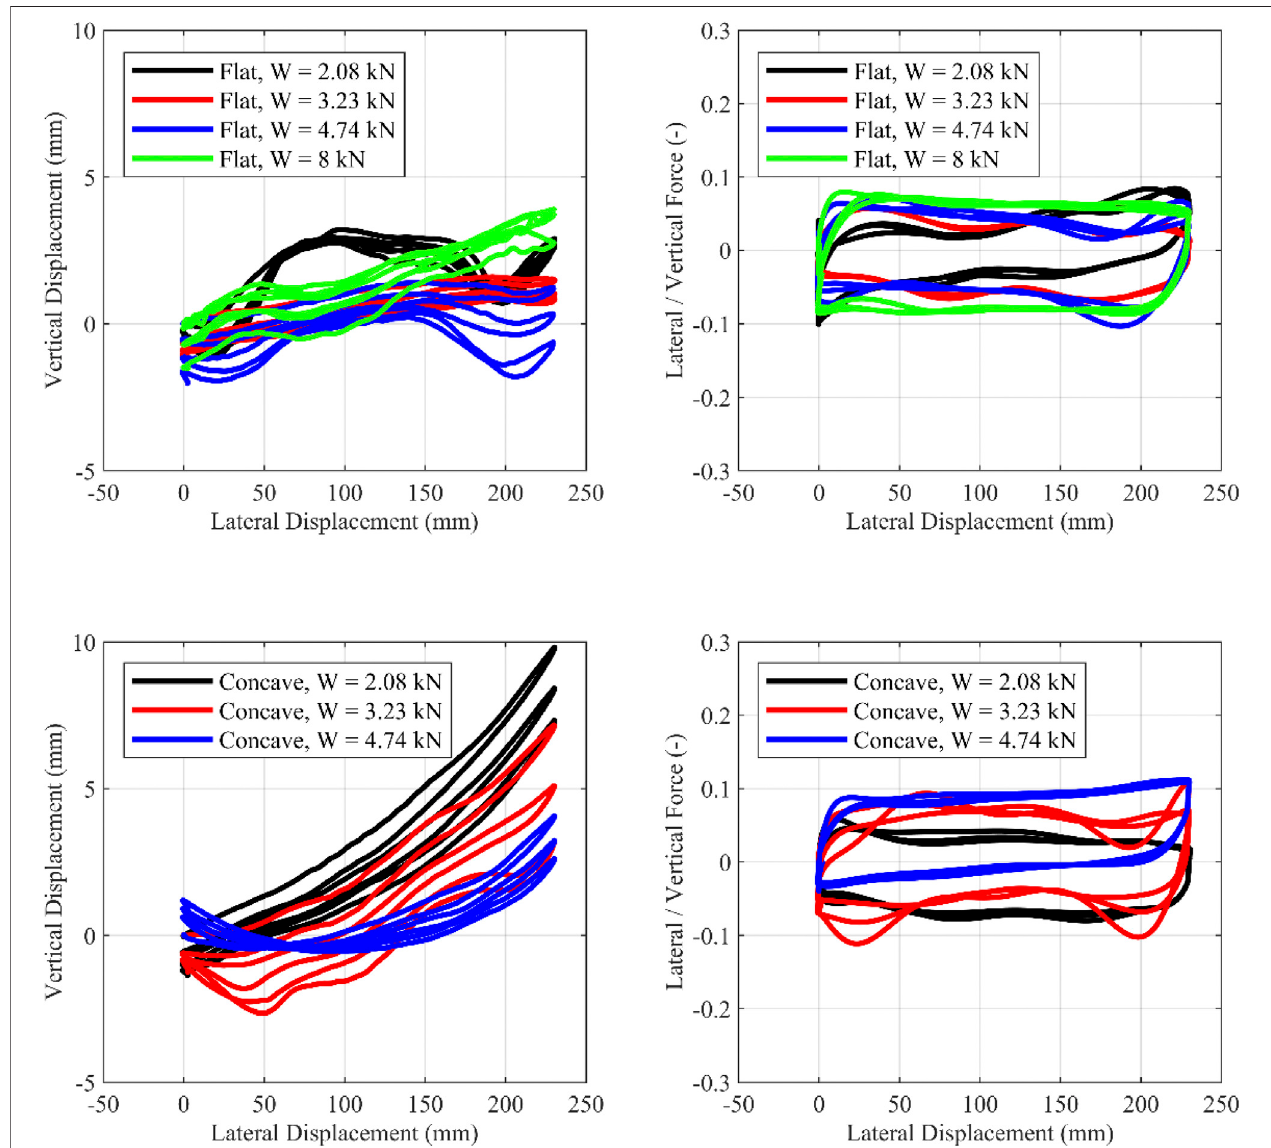
FIGURE 7 | Cyclic motion 0/+230 mm. In fl uence of the vertical load. Left , Vertical-horizontal displacement; Right , Lateral/Vertical force — Lateral displacement.